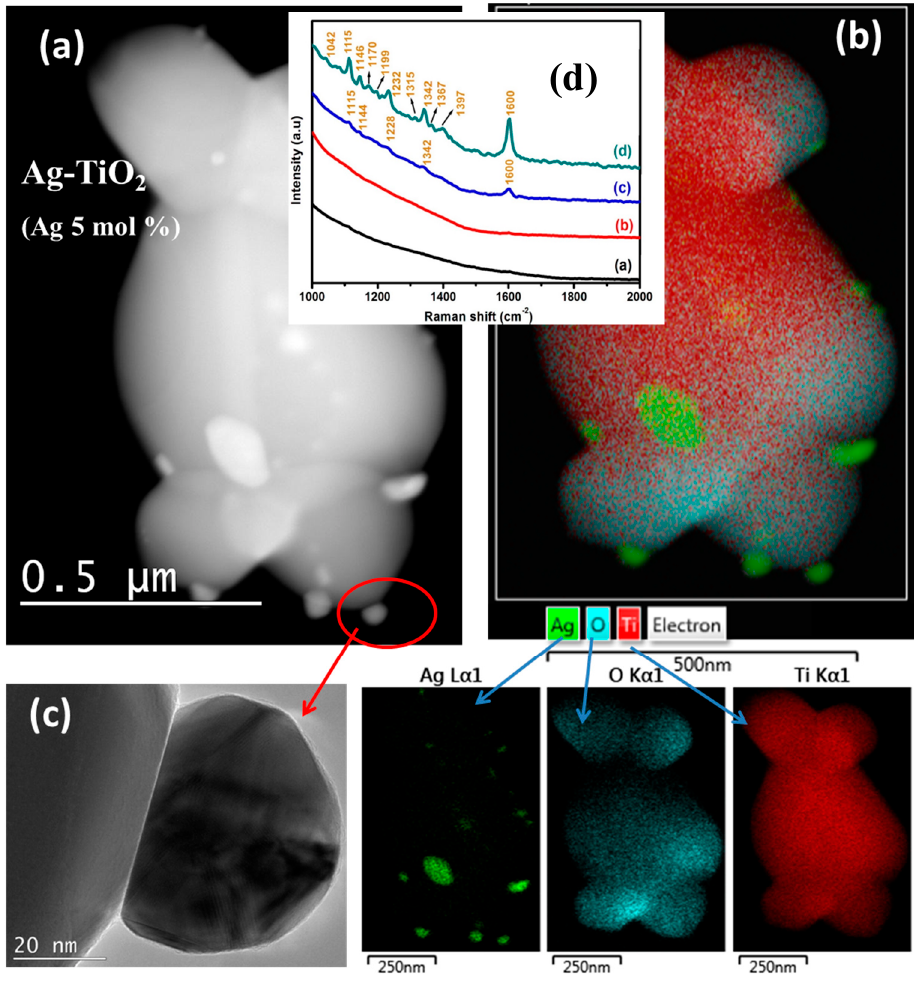
Figure 16. ( a ) Layered image, high-angle annular dark-field (HAADF) STEM micrograph; and ( b ) corresponding EDS mapping of Ag-TiO 2 nanocomposites with a 5 mol % concentration (including EDS maps with HAADF micrograph). Individual EDS Maps for the elements Ag, O and Ti are shown. ( c ) HRTEM image of an Ag NP that sits on the surface of the TiO 2 particle. Inset ( d ) shows the SERS signals of the aqueous MO solution on the surface of the: ( a ) TiO 2 ; and Ag-TiO 2 nanocomposite particles with Ag: ( b ) 1 mol %; ( c ) 3 mol %; and ( d ) 5 mol % [61].